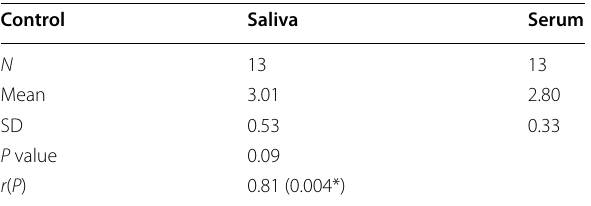
Table 5 Mean and standard deviation of saliva and serum in control